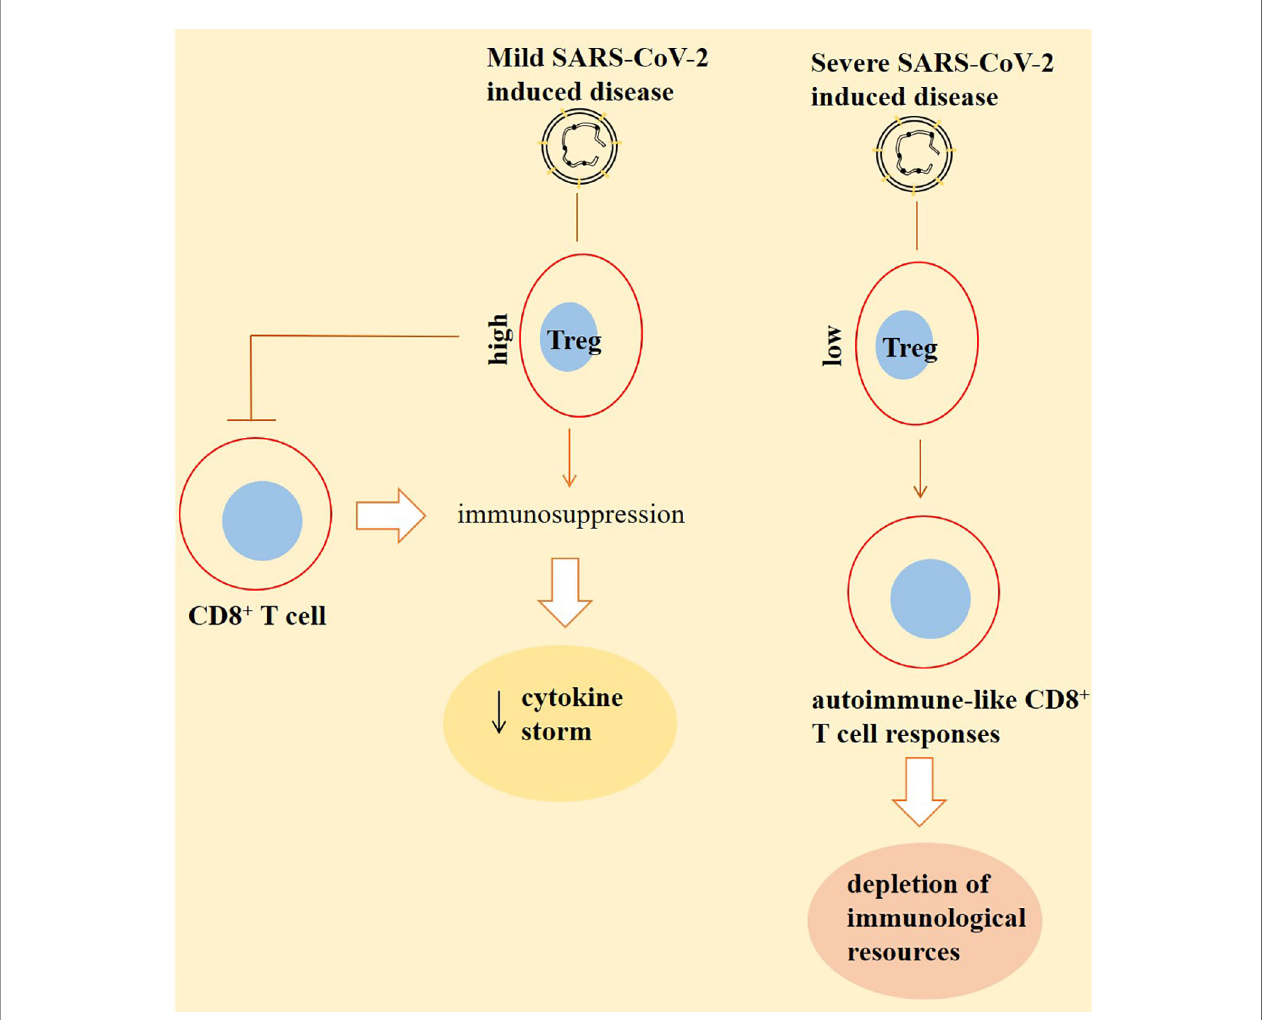
FIGURE 2 | Inverse cross talking between CD8 + T cells with regulatory T cells (Tregs) in patients with a SARS-CoV-2-induced disease. Tregs are high in patients with a mild disease. This will result in immunosuppression partly by suppressing the activity of CD8 + T cells. Such immunosuppression further reduces the extent of cytokine storm, thereby lessening the severity of the condition. By contrast, the number of Tregs is low in severe cases. This will cause responses from CD8 + T cells to self-antigens, and the cells are representing autoimmune-like states, which results in the depletion of immunological resources to combat against the virus. The outcome of this autoimmunity is higher viral persistence and a more severe